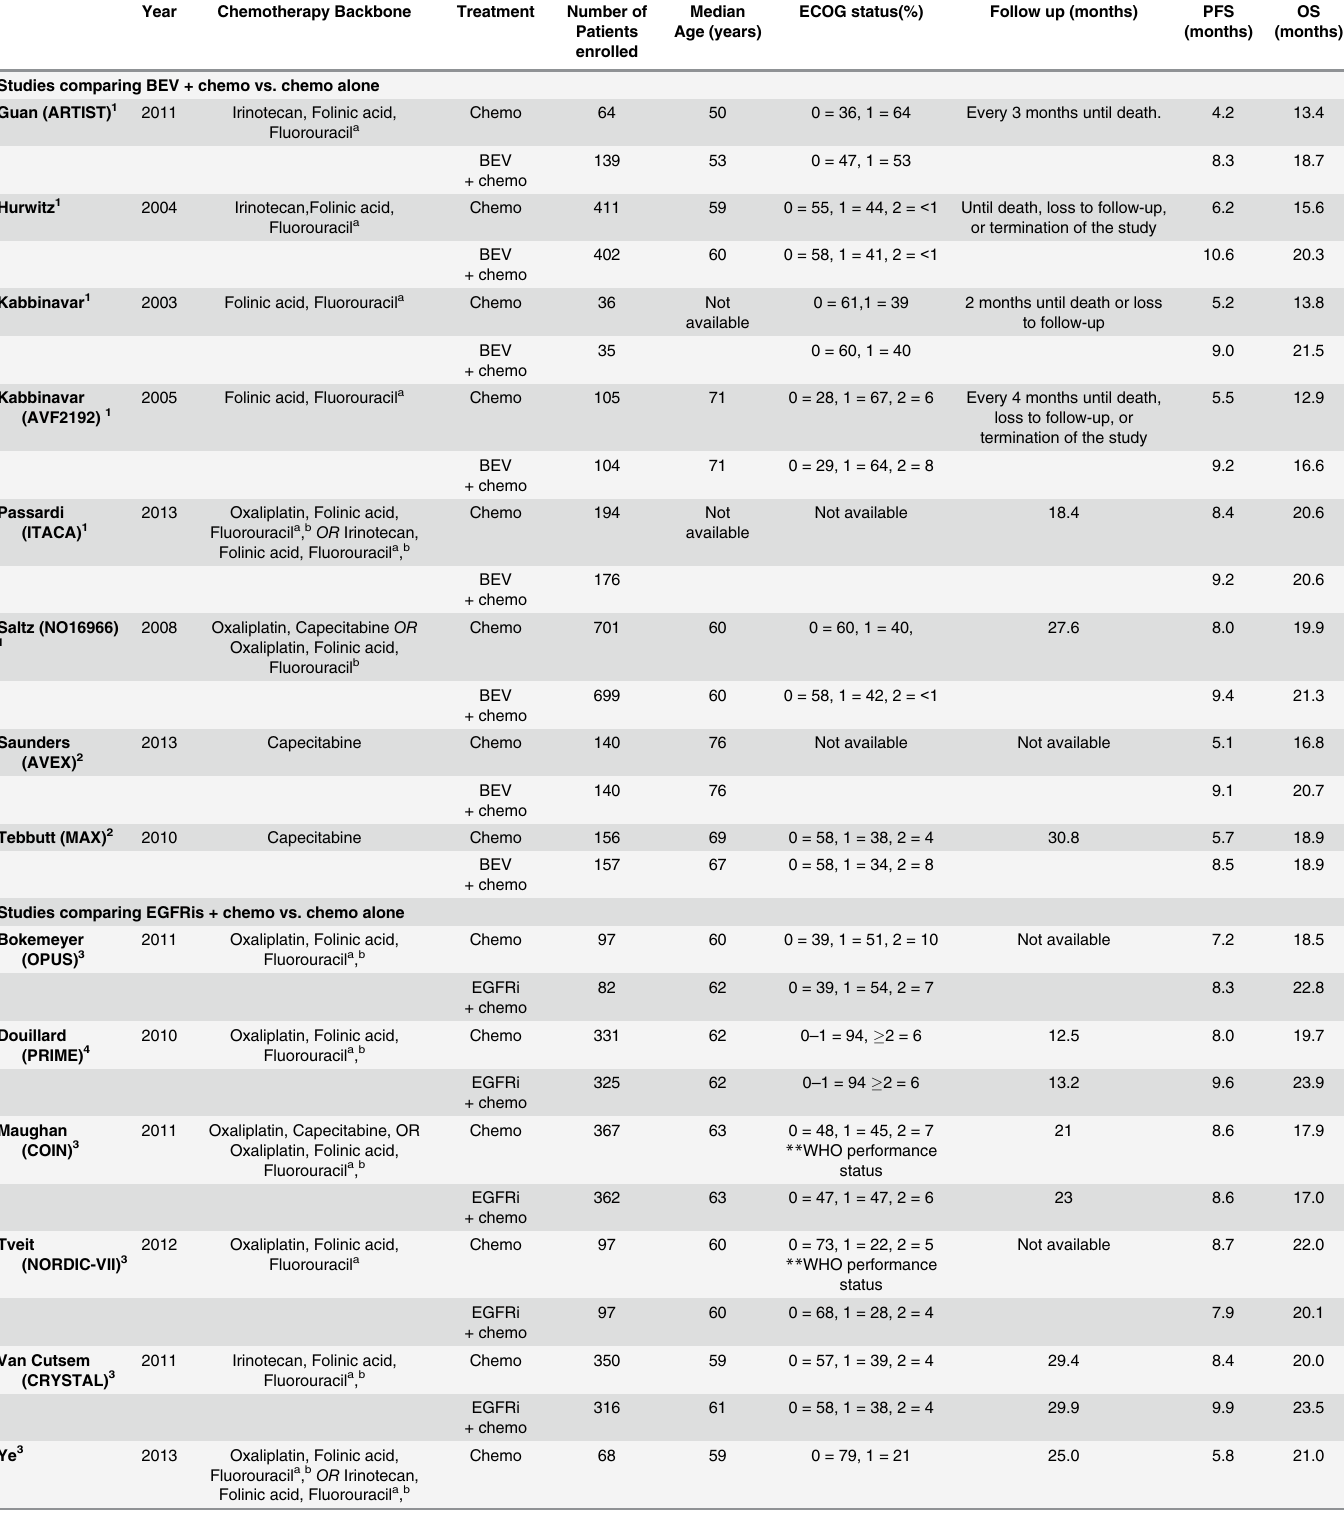
Table 1. Characteristics of eligible trials. The demographics included in the above table pertain only to patients included in our analysis. Year Chemotherapy Backbone Treatment Number of